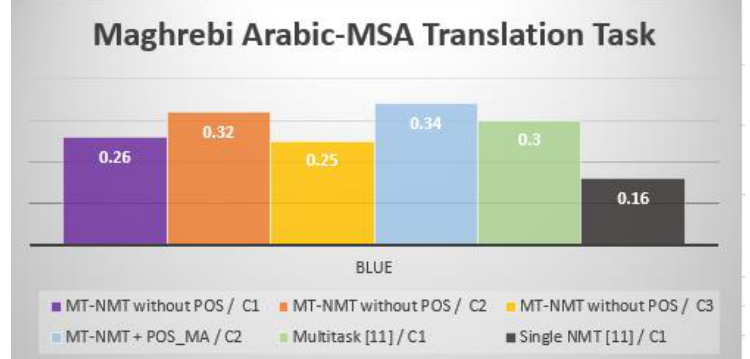
Figure 5. Levantine Arabic-MSA BLEU score with different models, where C1 is a randomly initialized embeddings, C2 a pre-trained/FastText and C3 a pre-trained/polyglot.